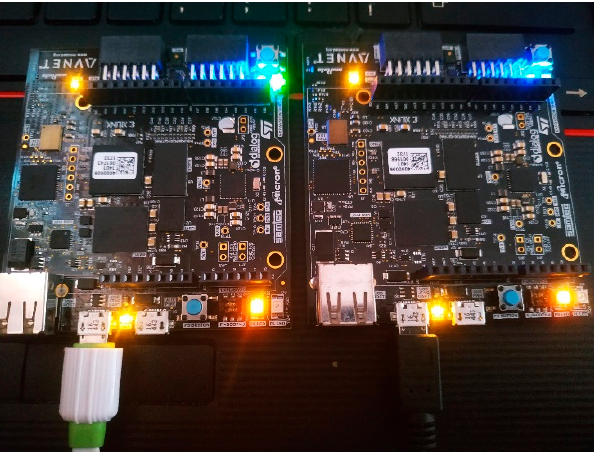
Figure 9. Experimental setup for TLS handshaking.